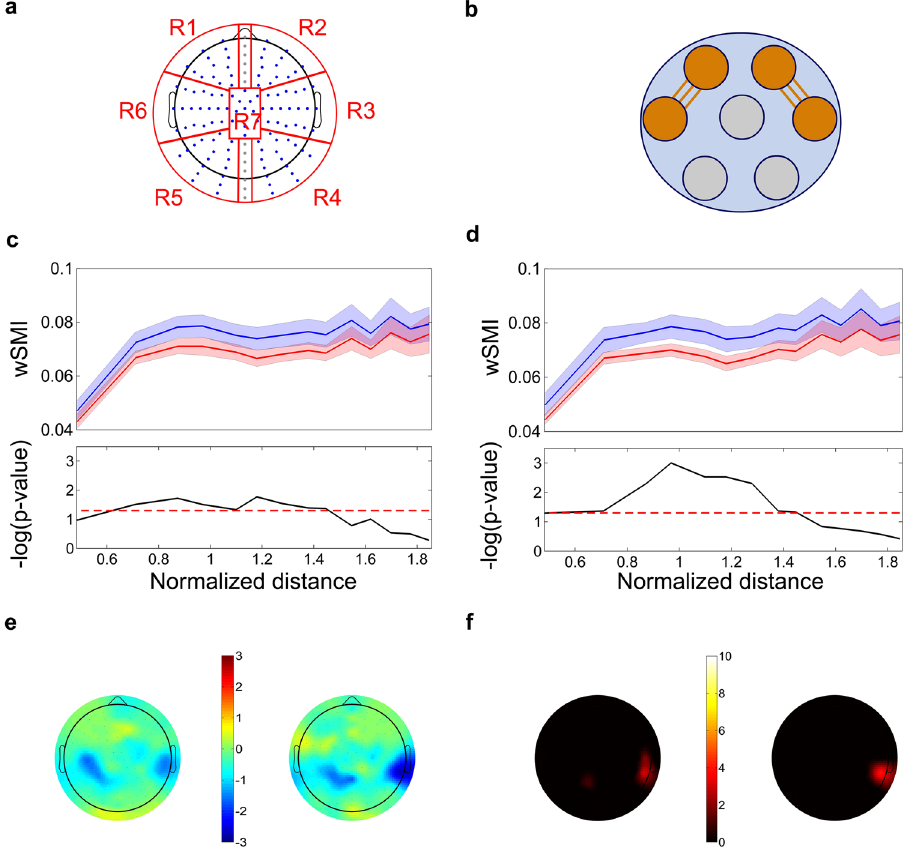
Figure 1. Functional connectivity analysis. ( A ) ROIs defined to analyze specific topographic connectivity: left frontal (R1), right frontal (R2), right temporal (R3), right posterior (R4), left posterior (R5), left temporal (R6), and central (R7). ( B ) Average connectivity between regions: significant differences for the average connectivity were found between the right frontal and right temporal ROIS (bvFTD: M = 0.06, SD < 0.01; controls: M = 0.07, SD = 0.01), and between the left frontal and the left parietal ROIs (bvFTD: M = 0.06, SD < 0.01; controls: M = 0.07, SD < 0.01). ( C ) Connectivity as function of distance of the left frontal ROI: bvFTD patients (red) and controls (blue). Results are shown as -log ( p -value) by distance; p -values crossing the dotted line are < 0.05. ( D ) Connectivity as function of distance of the right frontal ROI: bvFTD patients (red) and controls (blue). Results are shown as -log ( p -value) by distance; p -values crossing the dotted line are < 0.05. ( E ) Seed analysis (median values): scalp maps of the median value of p -values (from Wilcoxon test between bvFTD patients and controls) are shown for the left frontal (left) and right frontal (right) seeds. The color bar indicates -log [median ( p -values)] times the sign of W, where W is the Wilcoxon statistics minus the expected value under the null hypothesis. Values > 1.3 or < − 1.3 are statistically significant. ( F ) Seed analysis (FDR correction): scalp maps quantifying the number of connections (associated to the seed ROI) yielding differences ( p -value from Wilcoxon test between bvFTD patients and controls with FDR < 0.05) for each electrode. The maps show the results for the left frontal (left) and the right frontal (right) seeds. The color bar indicates the number of connections with statistically significant differences ( p -values <